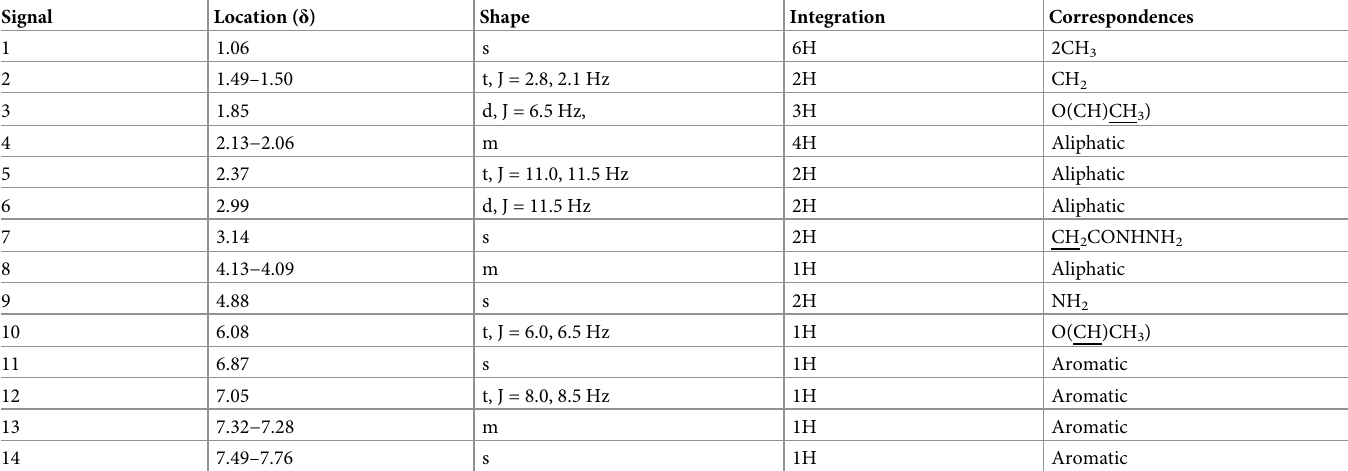
Table 1. 1 H-NMR spectral data of acetohydrazide derivative of CZT. Signal